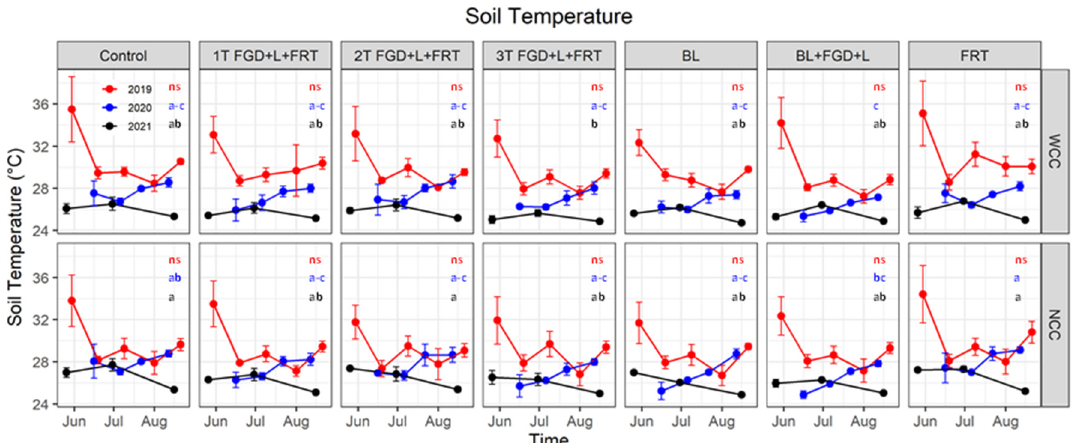
Figure 3. Soil temperature at sampling events. Red, blue and blacklines represent soil temperature in 2019, 2020 and 2021, respectively. Solid cycles are the mean of replicates, and error bars are standard errors (n = 3). Red, blue and black letters show the results of Tukey’s multiple comparison tests for 2019, 2020 and 2021, respectively, with no letter in common denoting significant differences at α = 0.05 (ns: no significant difference). WCC: with cover crop; NCC: no cover crop.